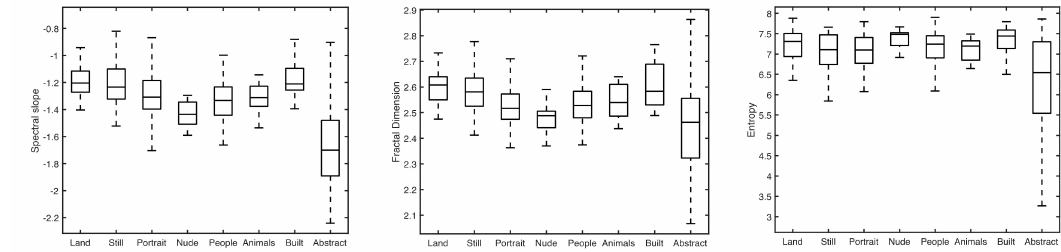
Figure 1. Boxplots of luminance statistics of different painting genres. Left: spectral slope. Middle: Fractal Dimension. Right: